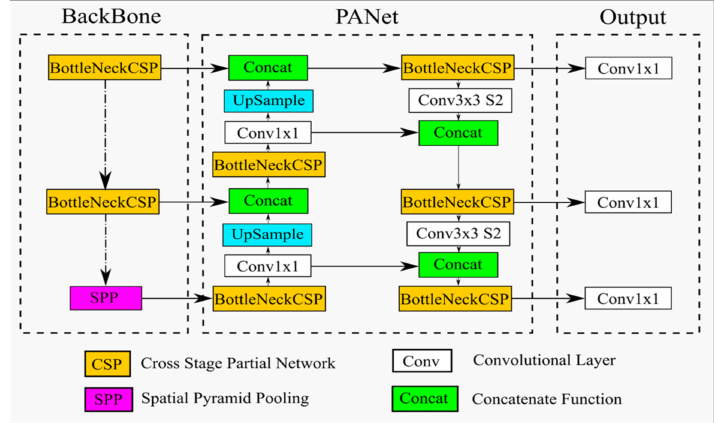
Figure 3. Network architecture of